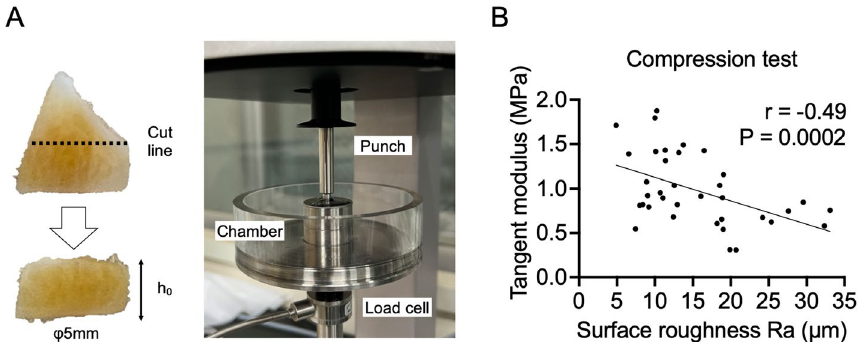
Figure 4. Correlation of surface roughness with biomechanical property in the meniscus. A total of 36 samples from six menisci were included in each study. ( A ) Sample preparation and apparatus used for compression test. ( B ) Correlation between surface roughness and tangent